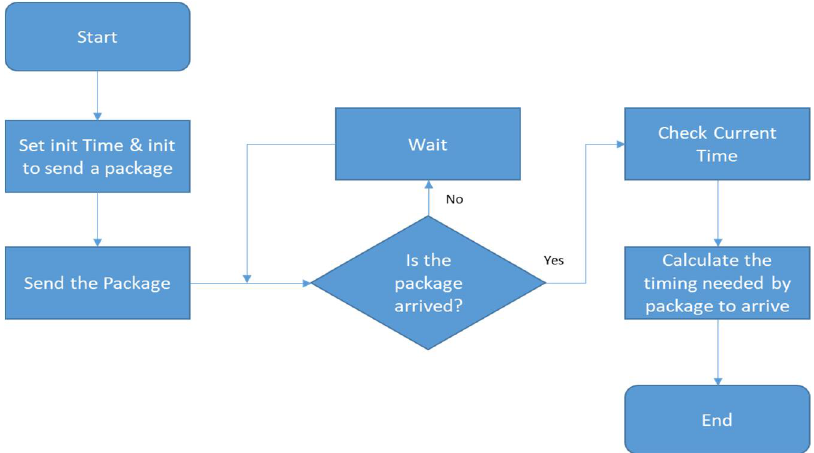
Figure 5. Delay measurement scheme.